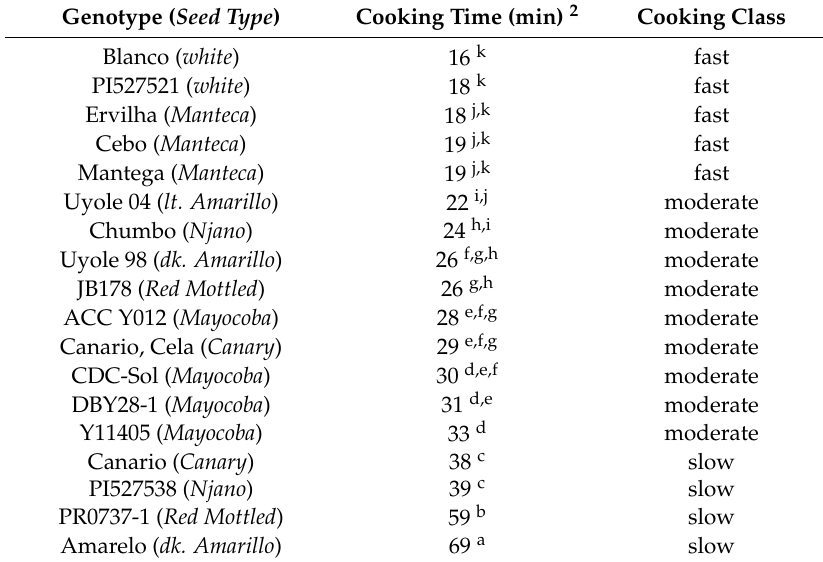
Table 2. Cooking Times of Pre-Soaked Genotypes in the Yellow Bean Panel 1